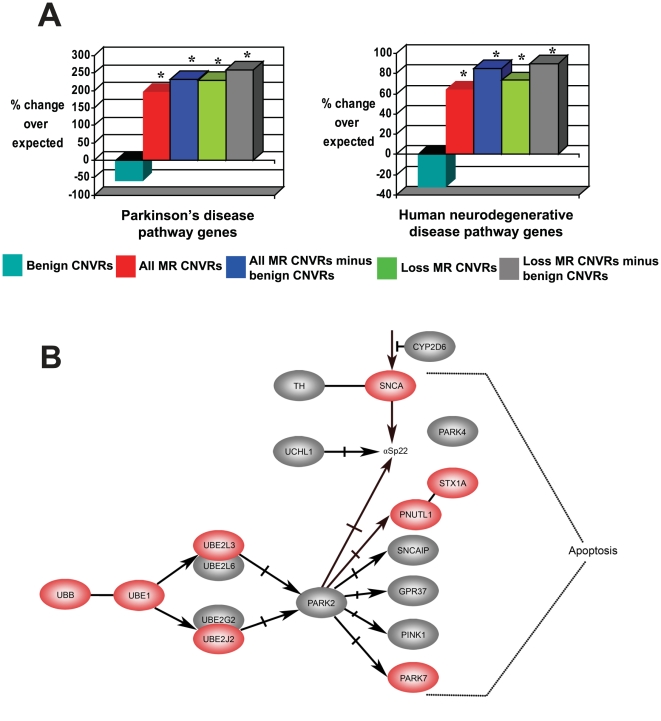
Human gene enrichments corroborate mouse phenotypic enrichments.(A) Enrichments of genes involved in Parkinson's disease or human neurodegenerative disease pathways that are overlapped by MR–associated CNVRs. These genes are described by KEGG as belonging to the Parkinson's disease pathway (HSA05020) or belonging to any of six neurodegenerative pathways (namely, HSA05010, HSA05020, HSA05030, HSA05040, HSA05050, and HSA05060). MR–associated CNVR sets denoted “minus benign CNVs” have had genes removed that are also overlapped by benign CNVRs showing the same direction of copy number change (i.e. Gain or Loss) as its overlapping MR–associated CNVR. Columns marked with an asterisk (“*”) are significantly enriched (FDR<5%). (B) All genes contained in the KEGG Parkinson's disease pathway (HSA05020). Of the 18 genes in this pathway, 8 (highlighted in red) are involved in a rare de novo CNV from at least one or more patients. The remaining genes (depicted in grey) lie outside of the 148 MR CNVs that we considered.